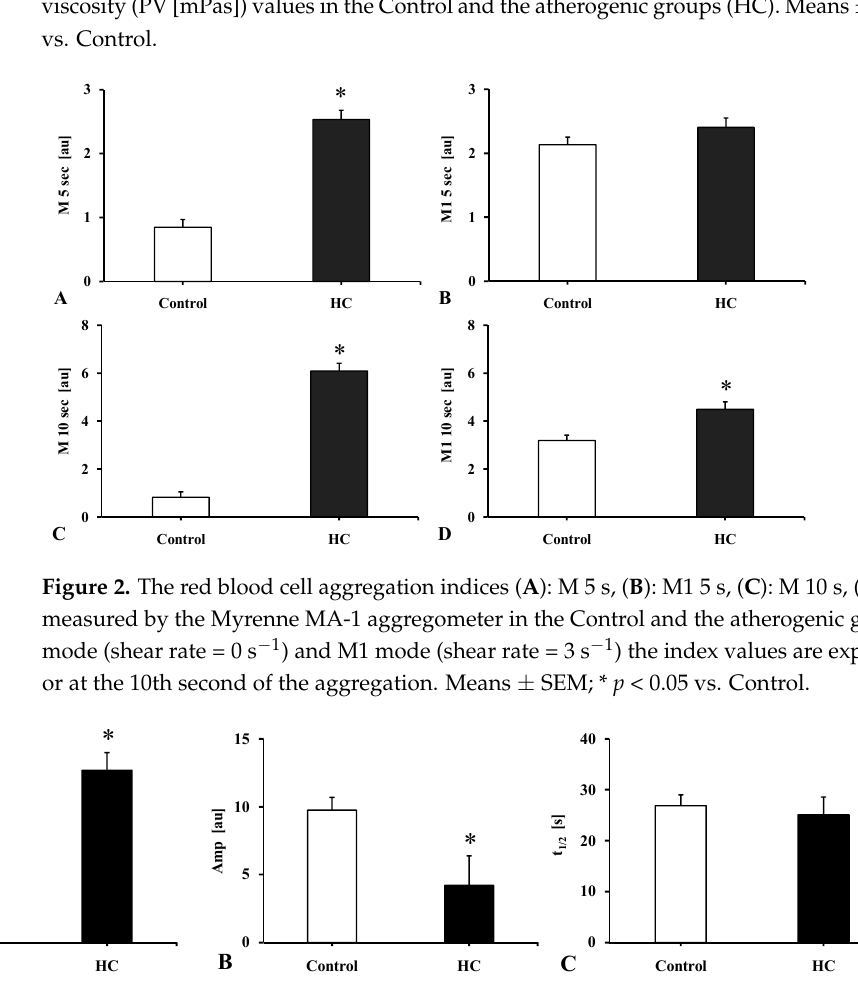
Figure 3. The red blood cell aggregation parameters measured by LoRRca rotational ectacytometer in the Control and the atherogenic group (HC). ( A ): aggregation index (AI [%]), ( B ): amplitude (Amp [au]) of the aggregation syllectogram (maximal-minimal intensity), ( C ): t 1/2 [s] representing the aggregation time at half Amp. Means ± SEM; * p < 0.05 vs. Control.